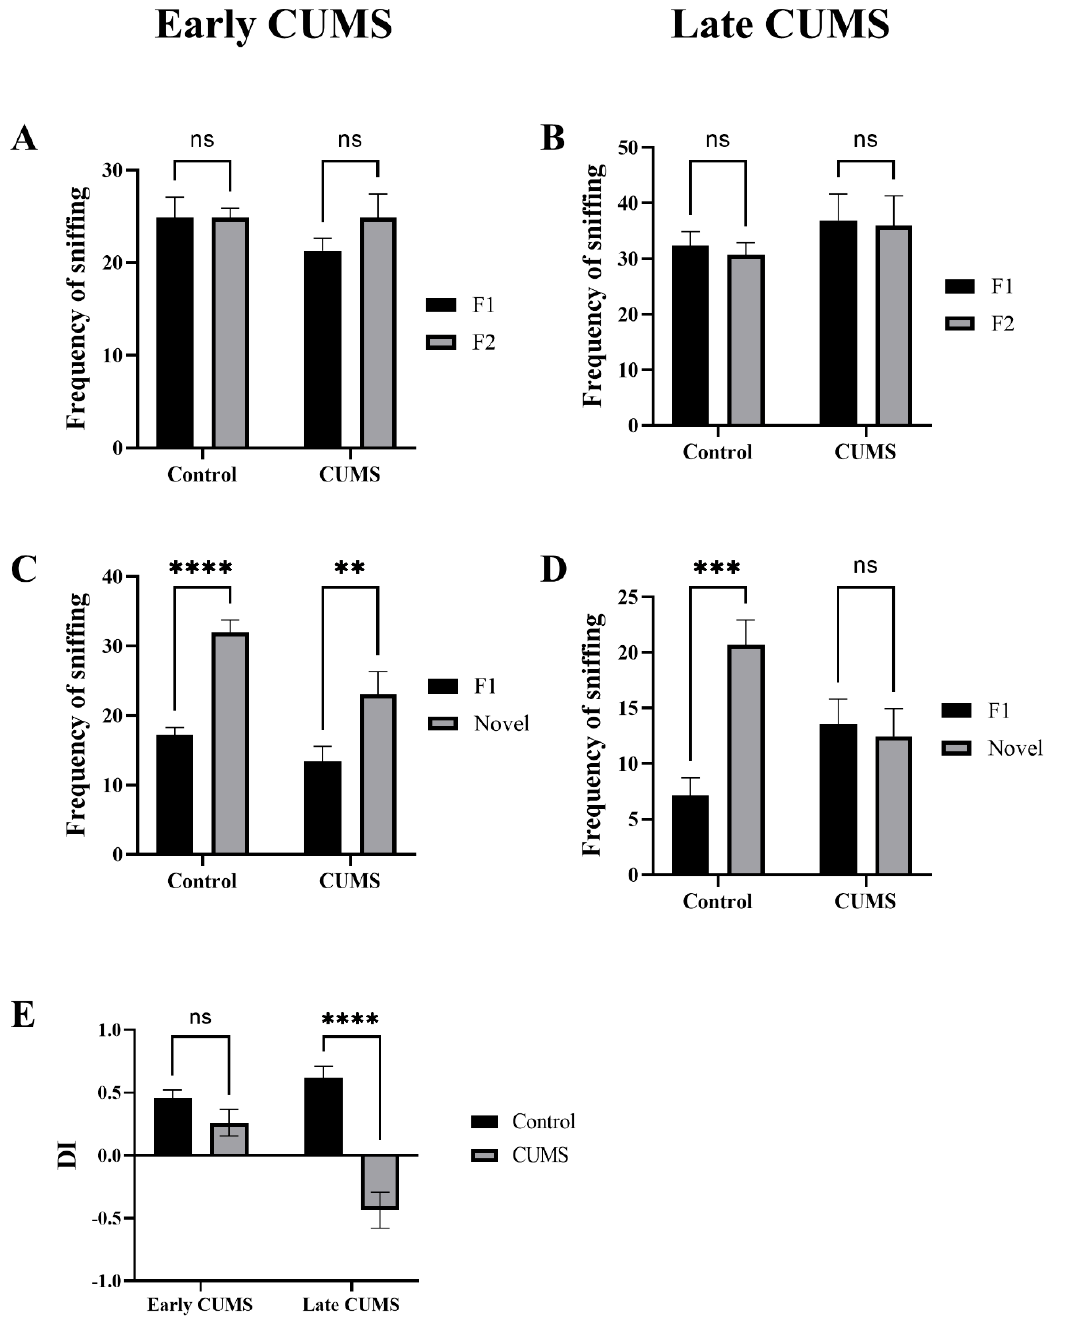
Figure 8. The effect of CUMS on recognition memory in the NORT task. The frequency of sniffing familiar objects (F1 and F2) in the familiarization stage in early ( A ) and late ( B ) CUMS. The frequency of sniffing objects (F1 and novel) in the test stage in early ( C ) and late ( D ) CUMS. The discrimination index (DI) is shown in ( E ). Two-way ANOVA was used, followed by Š í d á k’s multiple-comparisons test. (**) indicates a significant difference between the CUMS and the control group at p < 0.01, *** p < 0.001, and **** p < 0.0001. ns: not